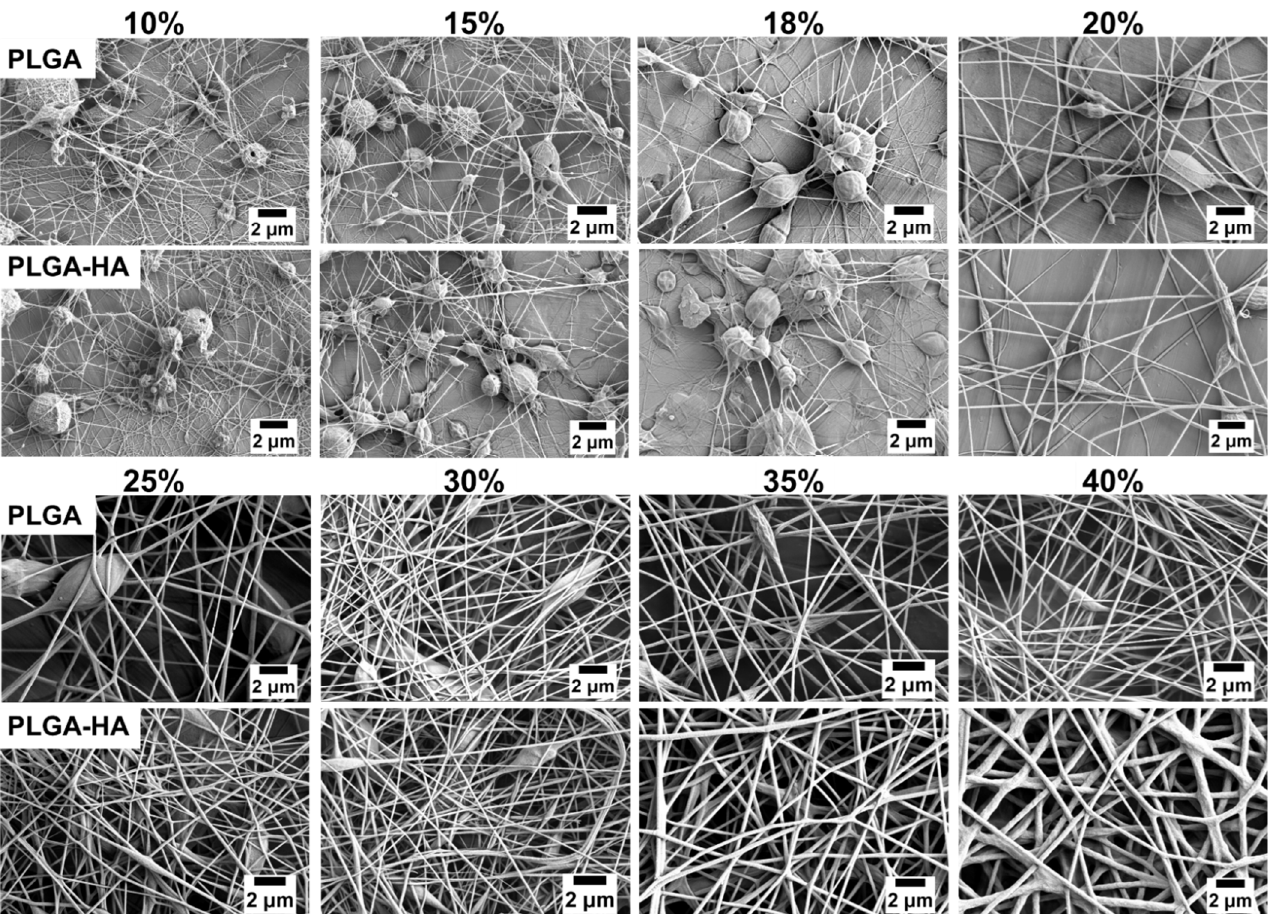
Figure 7. SEM results of electrospun nanofibers generated from pure PLGA in DMSO solutions and PLGA ‐ 1.5% HA in DMSO solutions with different concentrations of PLGA.